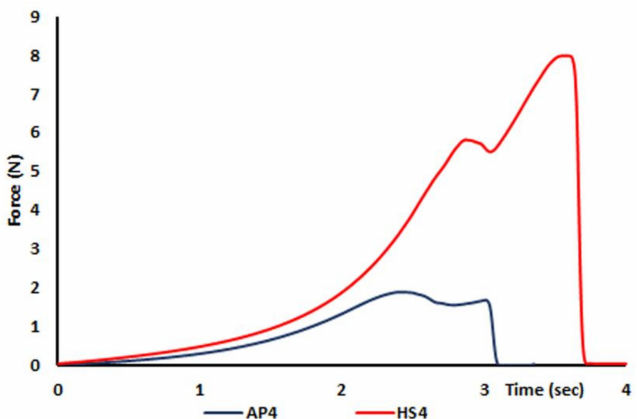
Figure 2. Mean (n = 15) force overtime curve of the wet AP4 and HS4 gel